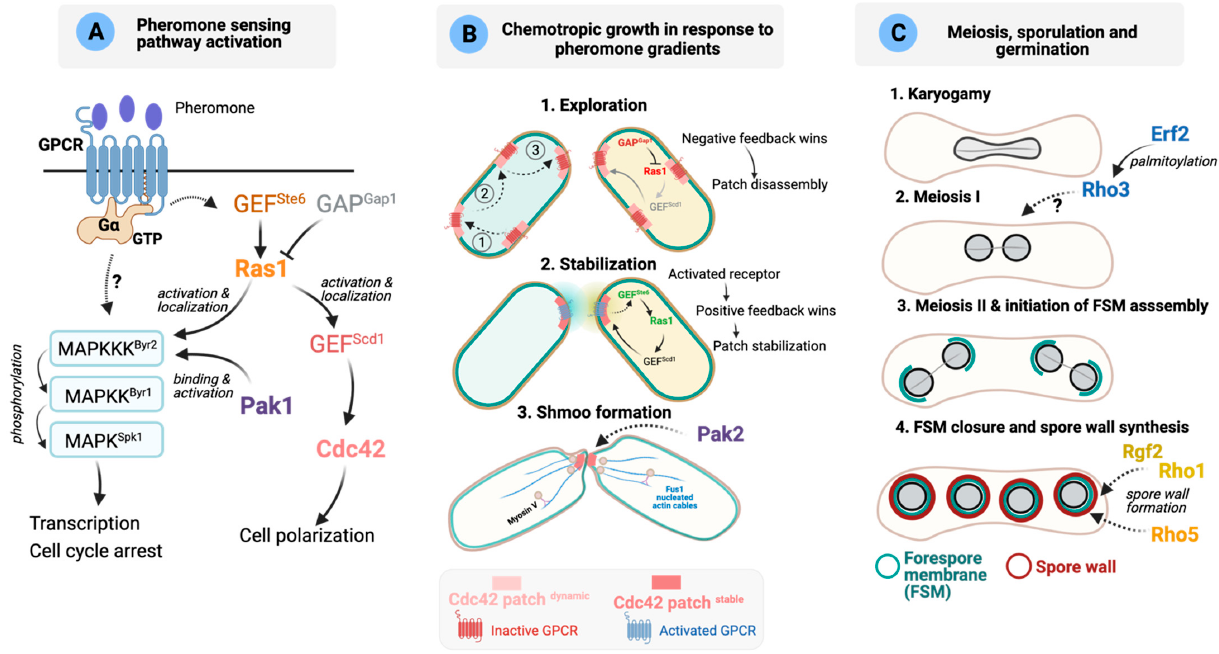
Figure 5. Functions of Rho GTPases during sexual differentiation (adapted from [7]). ( A ) GPCR (G-protein-coupled receptors) activation promotes MAPK signaling by the G α Gpa1 and the Ras GTPase. Ras1 also promotes Cdc42 activation for polarization during mating. ( B ) Cells form dynamic polarization zones that contain pheromone release and perception machinery that probe the environment for partner choice (exploration). The dynamic behavior requires patch destabilization promoted by negative control on Ras1. These zones are stabilized by opposite-type pheromones (represented in blue and yellow semicircles). Higher pheromone sensing promotes G α activation, which leads to enhanced Ste6 and Ras1 acti- vation and patch stabilization. Upon cell–cell contact, cell wall remodeling allows plasma membrane contact, fusion pore formation and pore expansion for zygote formation. Fus1 is a formin essential for fusion and for actin localization at the shmoo tip. The type V myosins serve to concentrate the cell wall glucanases to drive local cell wall dissolution for cell fusion. ( C ) Diagrammatic representation of sporulation stages in S. pombe . After cell pairing and fusion, the two nuclei fuse as well (karyogamy) and the resulting diploid nucleus undergoes meiosis. The zygote develops into an ascus, con- taining four dormant ascospores. The initiation of forespore membrane (FSM) assembly occurs during meiosis II. Shortly after, FSM extension encapsulates nucleus and cytoplasm and closure occurs. Finally, spore wall is synthesized. The role of several Rho GTPases during the different stages is shown in the figure. Dotted arrows mean that the molecular links have not been established. See main text for more details.